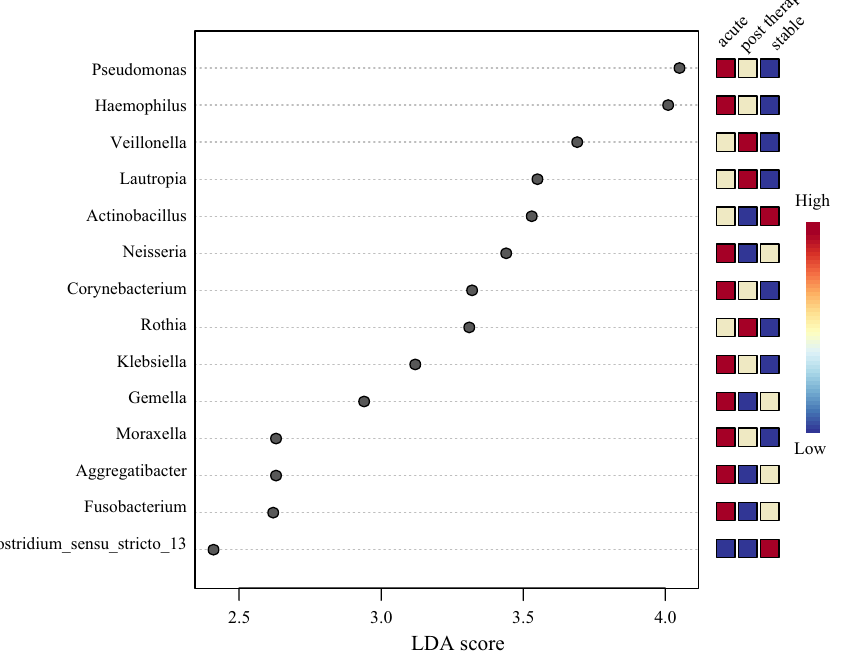
Figure 3. Histogram of LDA values of LEfSe analysis of respiratory microbiome with different disease status ( p < 0.05 by the Wilcoxon test). LDA linear discriminant analysis, LEfSe linear discriminant analysis Effect